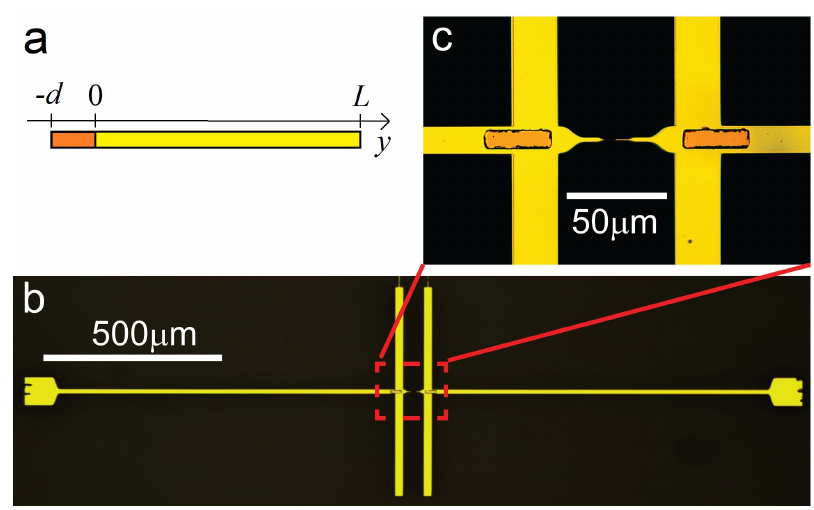
Figure 11: (adapted from Ref. [ 31 ] ) a: simplified geometry used to study the dynam- ics of quasiparticle density in the presence of a normal-metal trap. The trap region (orange) goes from − d to 0 and the superconductor without trap (yellow) from 0 to L . b: optical image of one of the devices used in the experiments. c: zoomed- in image of the copper traps (orange) deposited over aluminum (yellow) near the